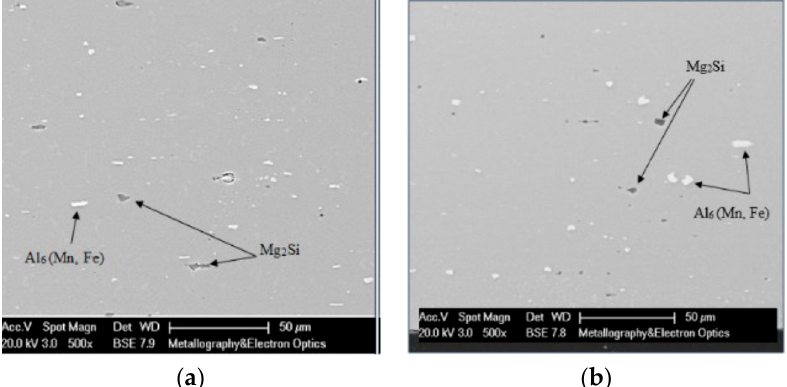
Figure 2. Scanning electron microscopy (SEM) images showing ( a ) h.r. sample and ( b ) c.r.2.